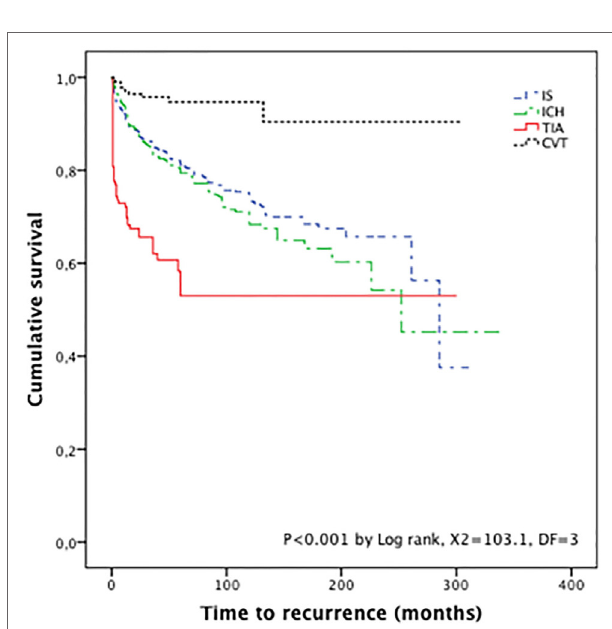
FigUre 3 | Kaplan–Meier survival curves for recurrence by stroke subtype. Abbreviations: IS, ischemic stroke; ICH, intracranial hemorrhage; TIA, transient ischemic attack; CVT, cerebral venous